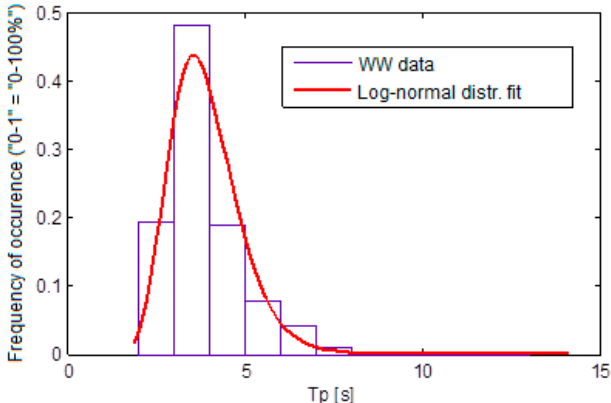
Figure 7. Log-normal conditional distribution fit of Tp on Hs , e.g., H s = 0.5–1.0 m; E 14.5–N 44.0. The sea state, H s and T p description are completed by determining the mean and the standard deviation values that define the log-normal distribution for the entire bin range of H s , as presented in Figure 8.